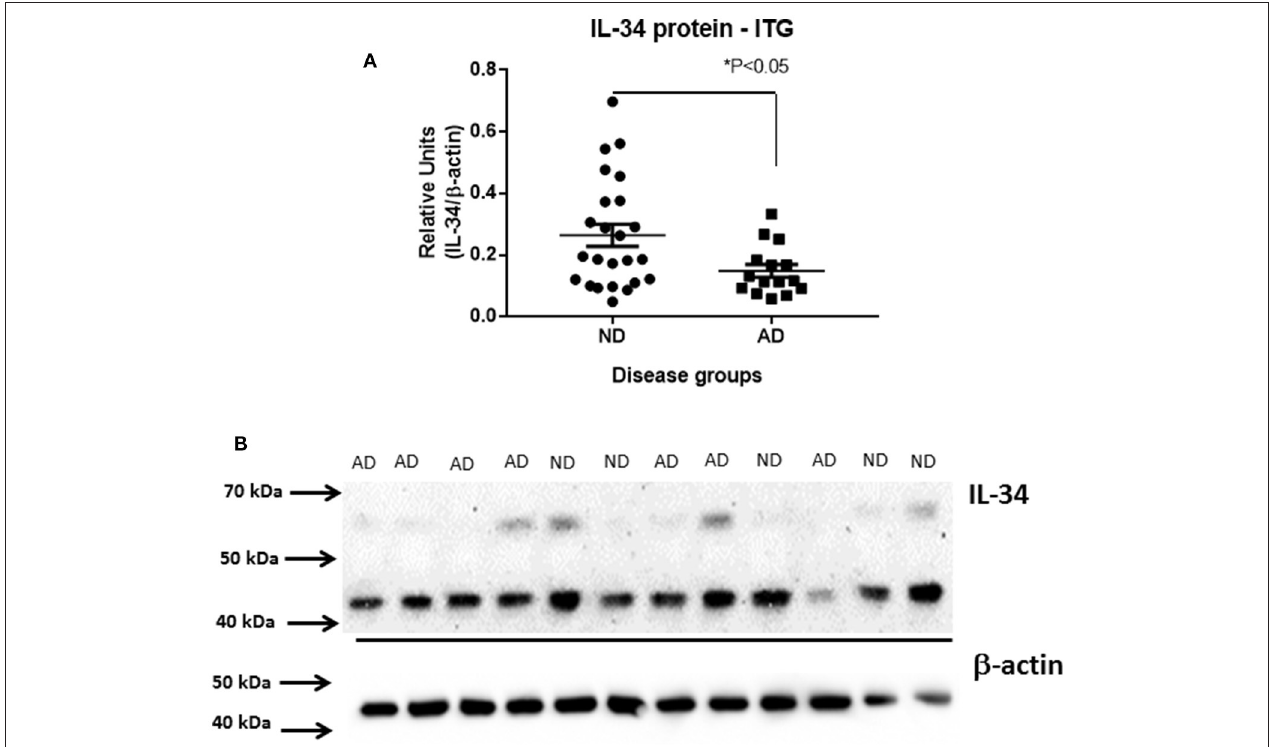
FIGURE 3 | Decreased levels of IL-34 protein in ITG samples of AD cases compared to ND cases. (A) Scatter plot showing relative levels of IL-34 protein, detected with AB74548 rabbit polyclonal antibody. Significant decrease ( P < 0.05) in IL-34 protein levels in AD cases. (B) Representative western blot of IL-34 protein detected in a range of brain samples analyzed in (A) . A major band of 45 kDa was detected but an additional band of approximately 60 kDa was detectable with longer